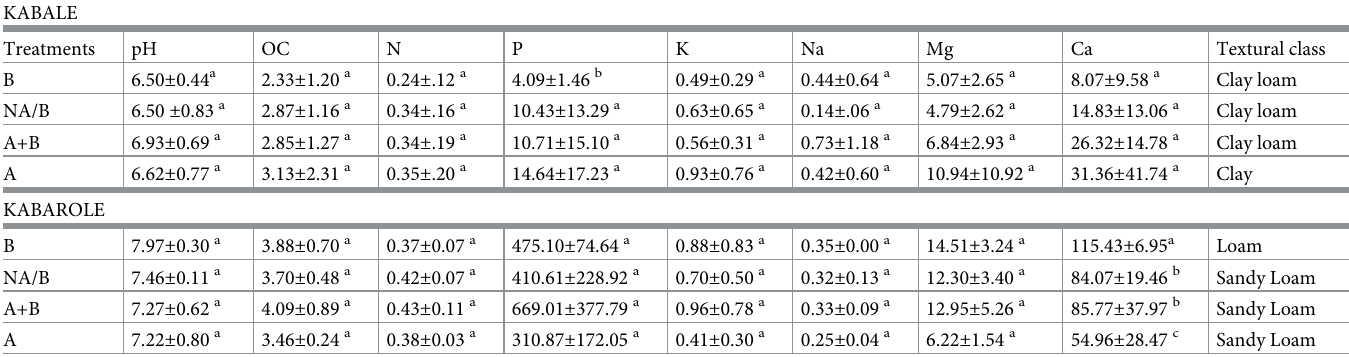
Values are expressed as mean ± standard deviation, for each study site, mean values in the same column having different letters are significantly different using ANOVA (p < 0.05) and multiple comparison of means was done using Least Significant Difference (LSD) (n = 16). B-beans only, NA/B- no beans and no A . annua , B+A- Beans and A . annua and A . annua